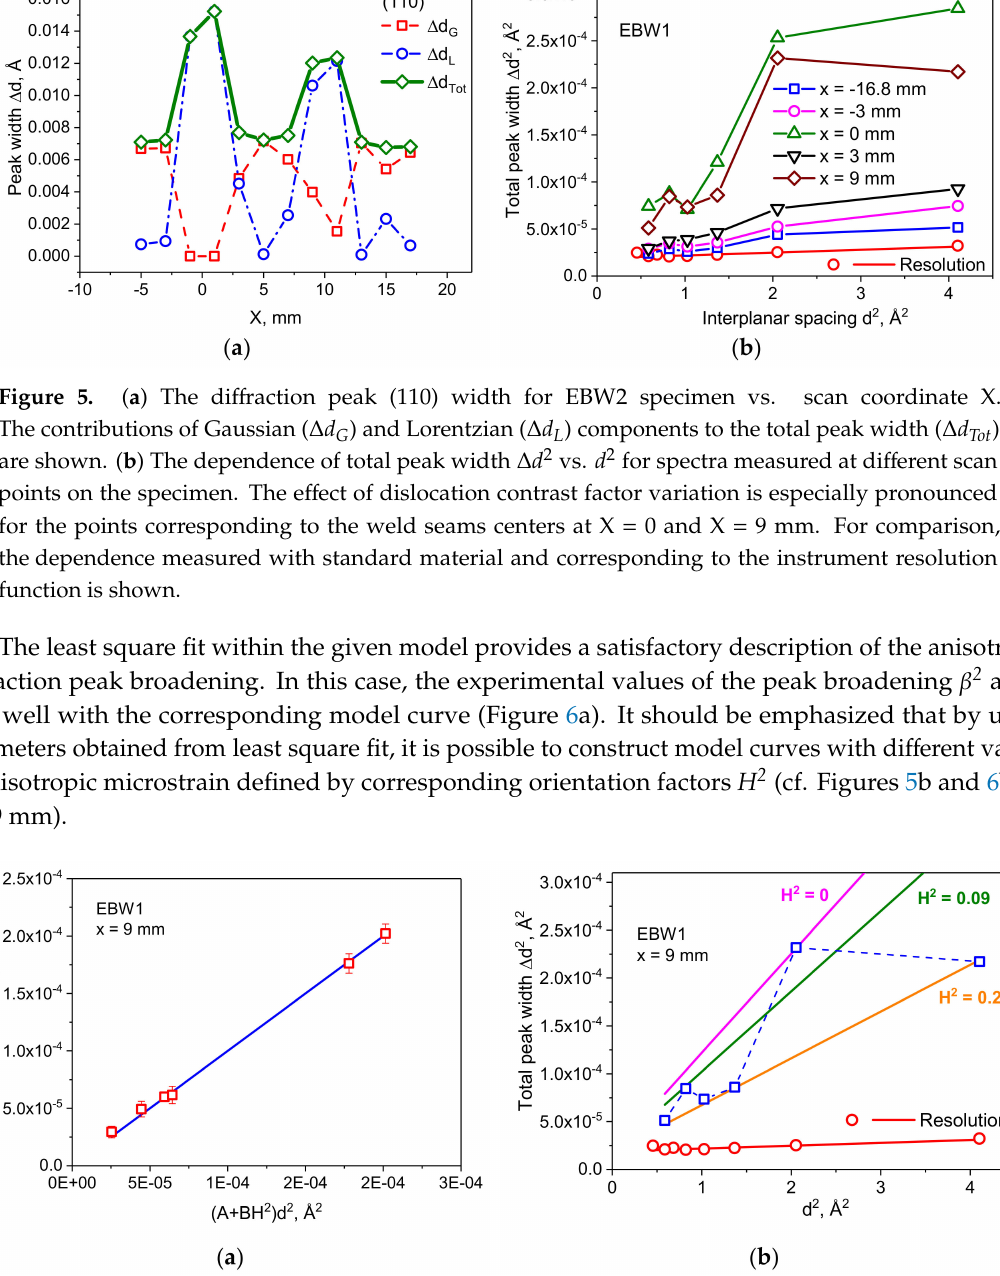
Figure 6. ( a ) The dependence of peak broadening β 2 vs. ( A + BH 2 ) · d 2 at the weld seam center (X = 9 mm). Squares designate experimental values, and the continuous line corresponds to the least square fit. ( b ) The dependence of total peak width ∆ d 2 vs. d 2 at the weld seam center (X = 9 mm). The continuous lines were plotted using the least square fit results and correspond to microstrain with di ff erent values of anisotropy factor H 2